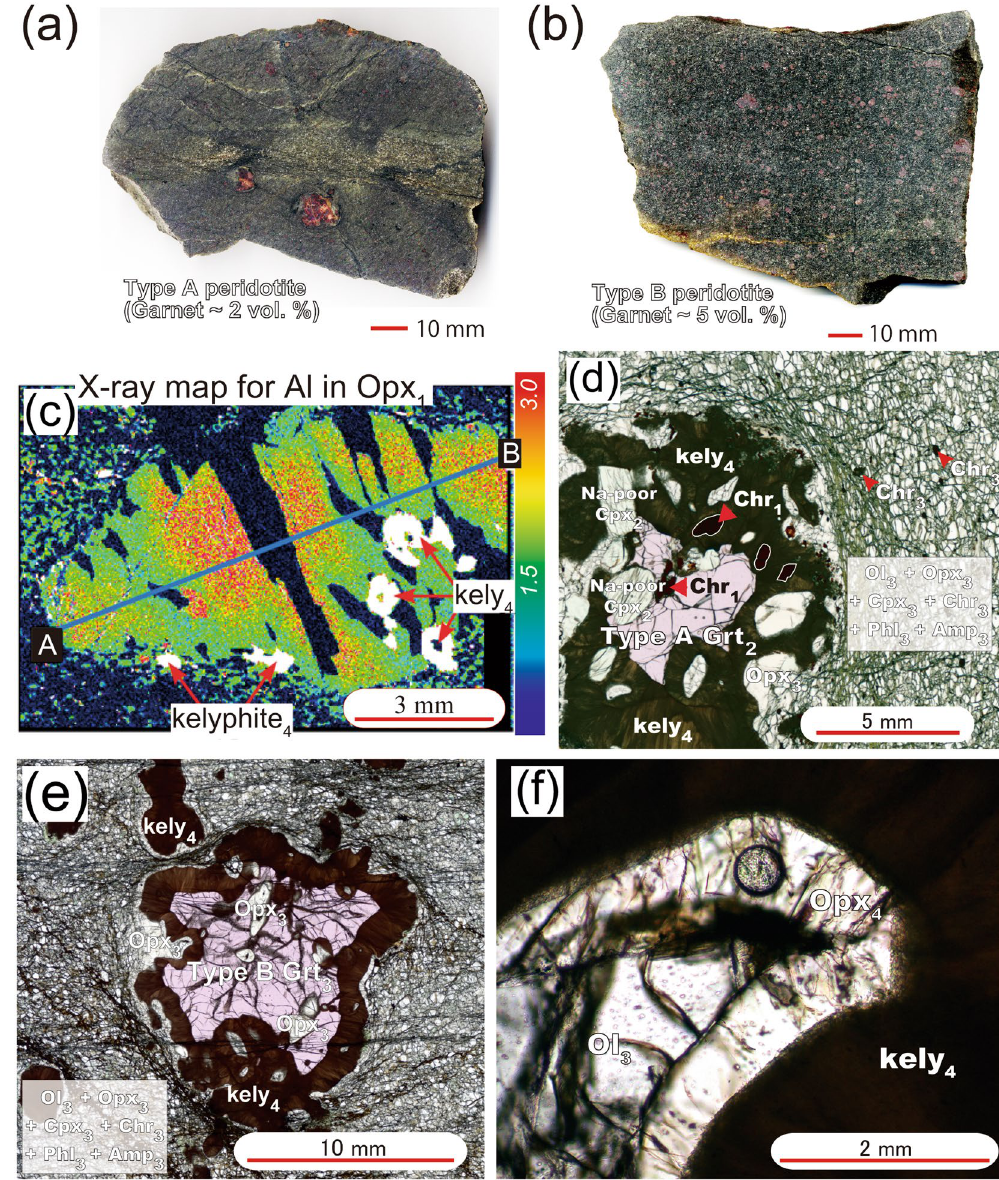
Figure 2. Panels (a) and (b) show typical Type A and B peridotites from the Plešovice quarry in the Bohemian Massif. Panel (c) shows Al 2 O 3 weight % concentration map of an orthopyroxene porphyroclast (Opx 1 ) stable at Stage 1 in a Type A peridotite. Crystallization stages are denoted by subscript numbers in figures. Chemical analyses along the traverse from A to B are shown in ref. 7 . Kelyphite (kely 4 ) formed after garnet (Grt). Matrix consists of olivine (Ol 3 ), Al-poor orthopyroxene (Opx 3 ), Na 2 O-rich clinopyroxene (Cpx 3 ), chromite (Chr 3 ), phlogopite (Phl 3 ), and calcic amphibole (Amp 3 ) that formed during Stage 3 7 . Panel (d) displays a centimetre- sized garnet (Grt 2 ) with Na 2 O-poor (~0.35 wt.%) Cpx 2 within embayments in a Type A peridotite. Plane polarized light. Panel (e) shows a Grt 3 with large Opx 3 inclusions within a Type B peridotite. Plane polarized light. Panel (f) shows a micrograph of kelyphite, which are separated from matrix Ol 3 by an orthopyroxene corona (Opx 4 ). Plane polarized